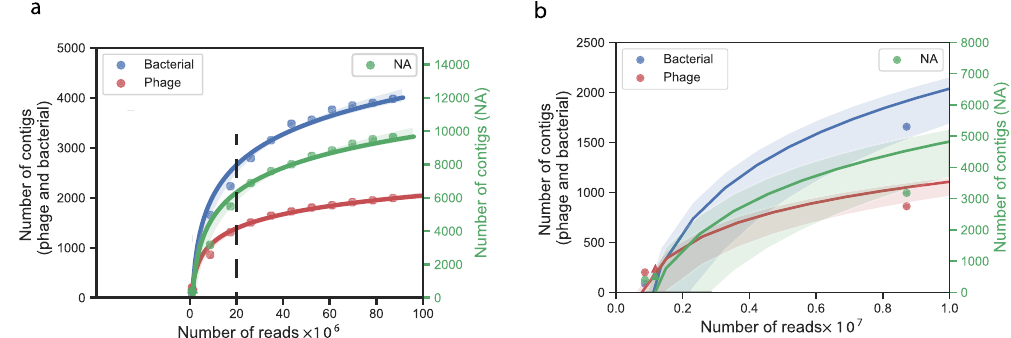
Figure 3. Analysis of the effect of sequencing depth on the number and type of contigs. ( a ) Contigs obtained by re-sampling the high coverage (HC) dataset at different depths. The black y-axis on the left indicates the number of contigs of phage and bacteria. The green y-axis on the right indicates the number of “NA” contigs. The vertical black dashed line represents the sequencing depth recommended (20,000,000 reads). ( b ) Zoom of ( a ) on 0 to 10 millions of reads, simulated data are in circles and observed data [from the low coverage (LC) dataset] in triangles. NA: non-attributable.